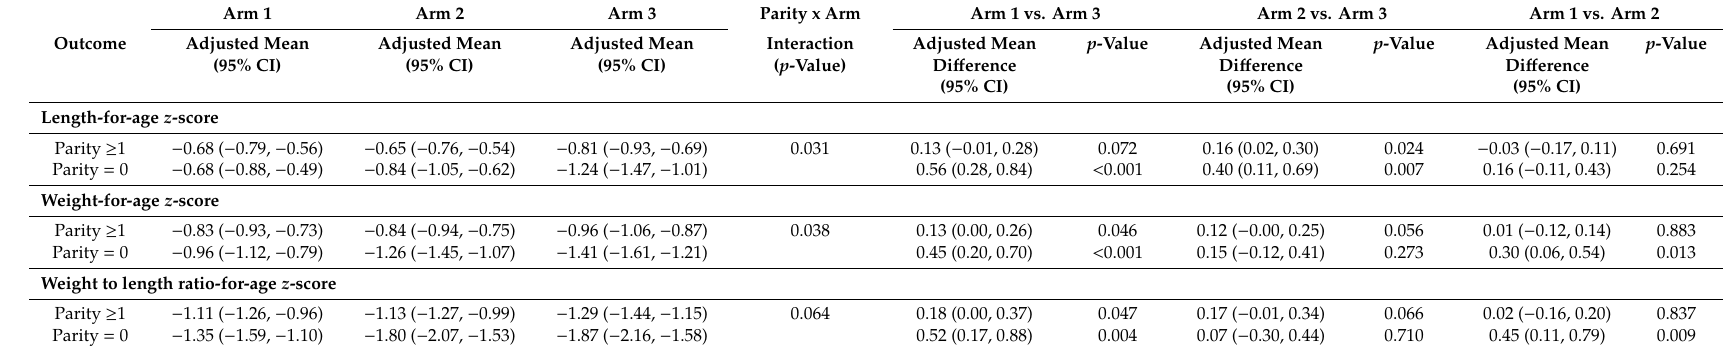
Table 3. Regression results of neonatal anthropometry by parity: combined